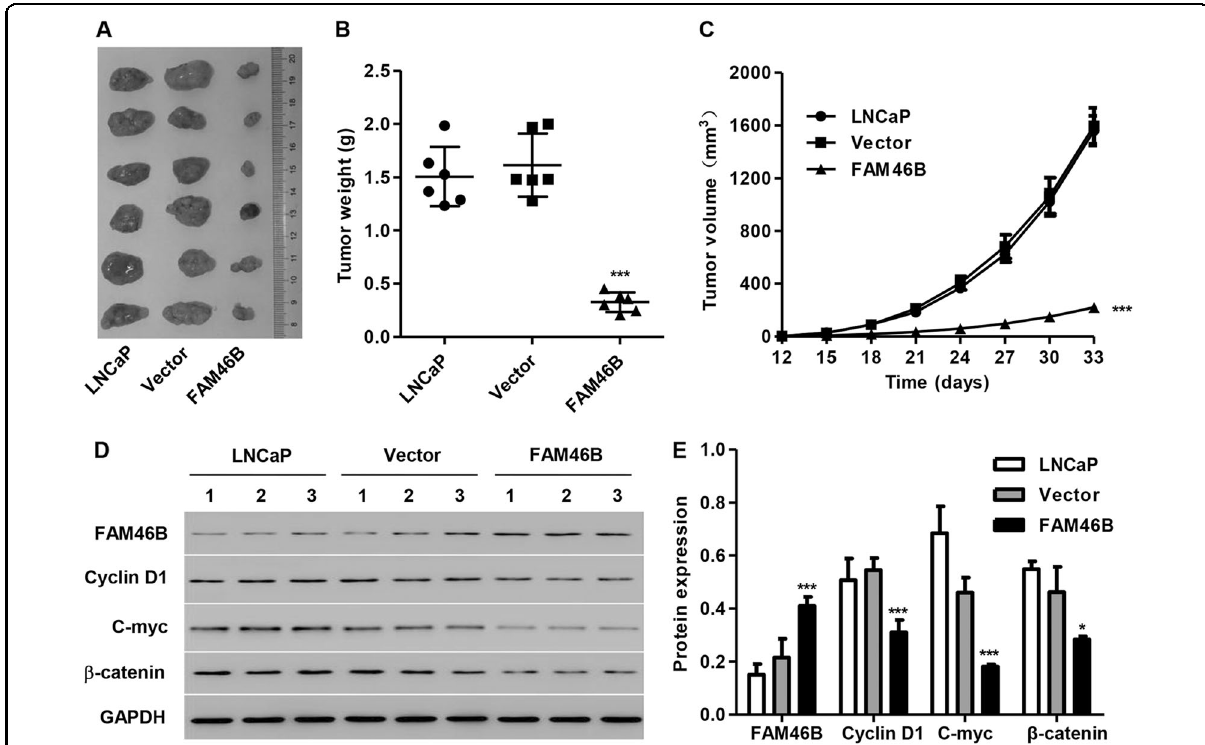
Fig. 5 FAM46B overexpression inhibited PC tumor growth in vivo After LNCaP cells were transfected with pLVX-Puro-FAM46B virus, they were injected into nude mice to establish a xenograft model; after 33 days, the tumor weight a , b and volume c were evaluated, and the protein expression of FAM46B, C-myc, Cyclin D1, and β -catenin were measured in xenograft tumors d , e by western blotting. * P < 0.05, *** P < 0.001 compared with blank